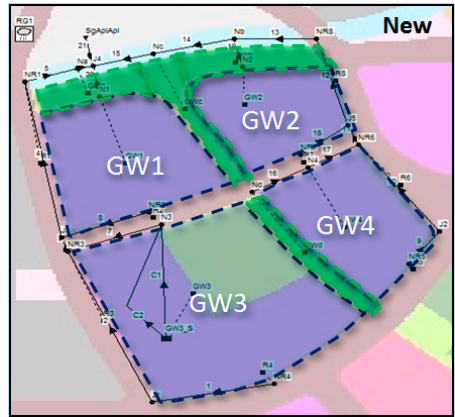
Figure 6. SWMM setup of the leaf concept design in Green Walk District (GWD).